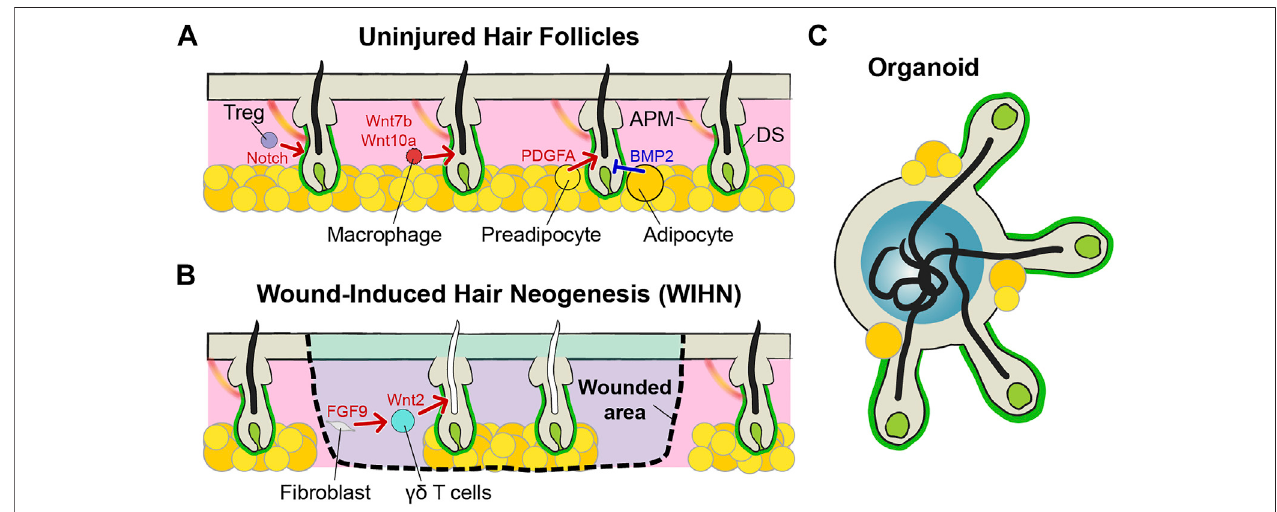
FIGURE 2 | Niches of hair follicles. (A) Mature hair follicles have many niche components around them. In addition to DP, there are dermal sheath (DS) cells, regulatory T (Treg) cells, macrophages, preadipocytes, adipocytes, and arrector pili muscle (APM). These components of the niches regulate the homeostasis of hair follicles,cooperatively. (B) Intermsofhairfolliclesfromwound-inducedhairneogenesis(WIHN),Wnt2andFGF9formapositivefeedbackloopandenhancethenewhair generation. Mostof theniches arecomposed, but melanocytes and APM are absent. Therefore, functionaldifferences exist, such asbeing able tocreate only gray hairs. (C) In the case of hair follicles made by organoids, the structures of hair follicles and DPs are similar to those of general hair follicles. Due to the limitations of the organoid culture methods, circulatory systems, including blood and lymphatic vessels, do not exist. In addition, other cellular and non-cellular components are not perfect, such as immune cells and extracellular matrix (ECM). However, unlike the WIHN-derived hair follicles, melanocytes exist and hair follicles from the organoid can produce pigmented hairs.